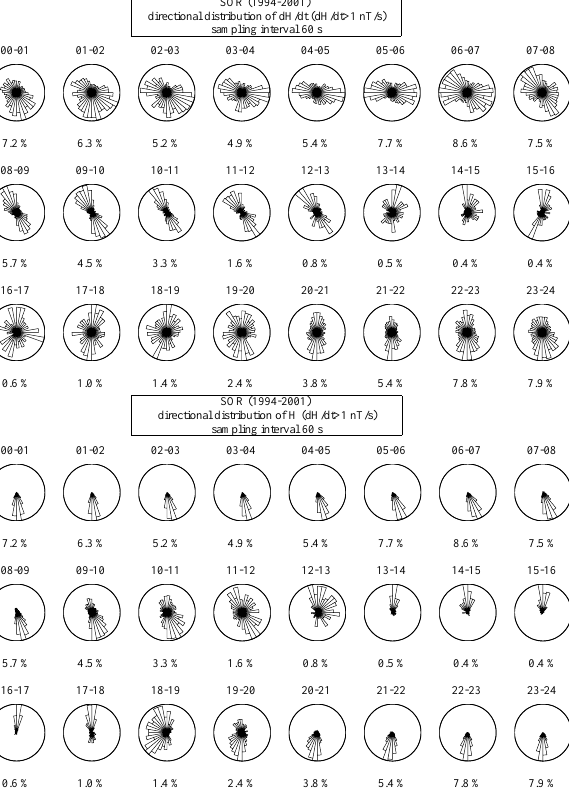
Fig. 9. Hourly distribution patterns of d H /dt and ∆ H at SOR from 1994 to 2001 for timesteps when | d H /dt | exceeded 1nT/s (one-minute data). The percentage of each hour of the whole day is given under subplots. Title texts show the magnetic local time (MLT) in the solar magnetic coordinate system (MLT = UT + 3 h 16 min for all timesteps used